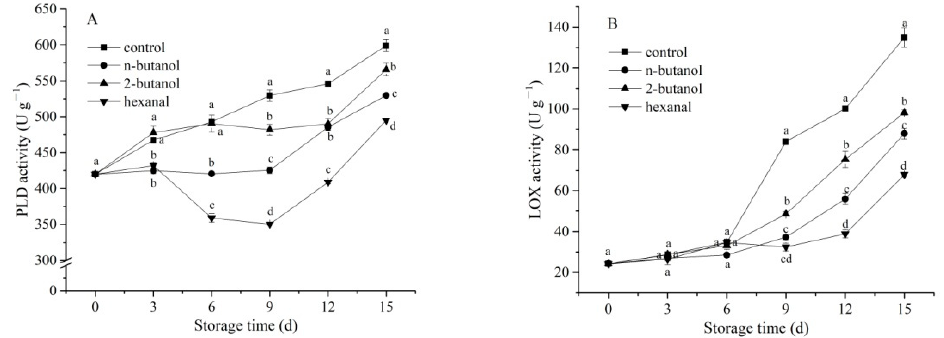
6 of 10 Figure 2. Effect of phospholipase D inhibitors treatment on cell membrane permeability ( A ) and MDA content ( B ) of postharvest banana fruit in response to mechanical wounding stress. The ver- tical bars in each mean indicate the standard error ( n = 3). Different letters among treatments at the same time point indicate significant differences ( p < 0.05). 3.3. Activities of PLD and LOX PLD is the initial enzyme involved in lipid degradation in the cell membrane. It is a key enzyme in phospholipid catalytic decomposition, which catalyzes the production of phospholipid degradation products, such as PA and choline [8]. The results of this study showed that PLD activity correlated with mechanical wounding. As shown in Figure 3A, PLD activity showed an overall increasing trend throughout the storage period. Com- pared with the control treatment, 2-butanol, n-butanol, and hexanal treatments signifi-